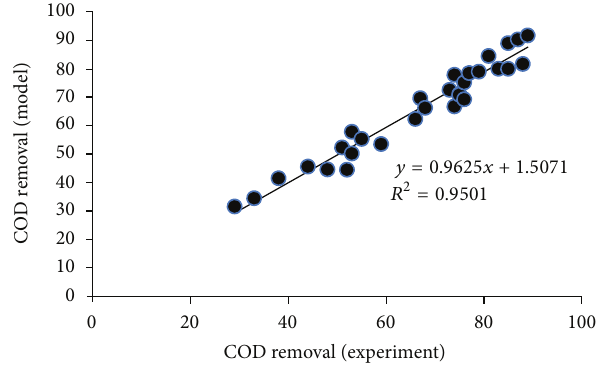
Figure 4: COD removal efficiency computed by the model versus the experimental COD removal efficiency.